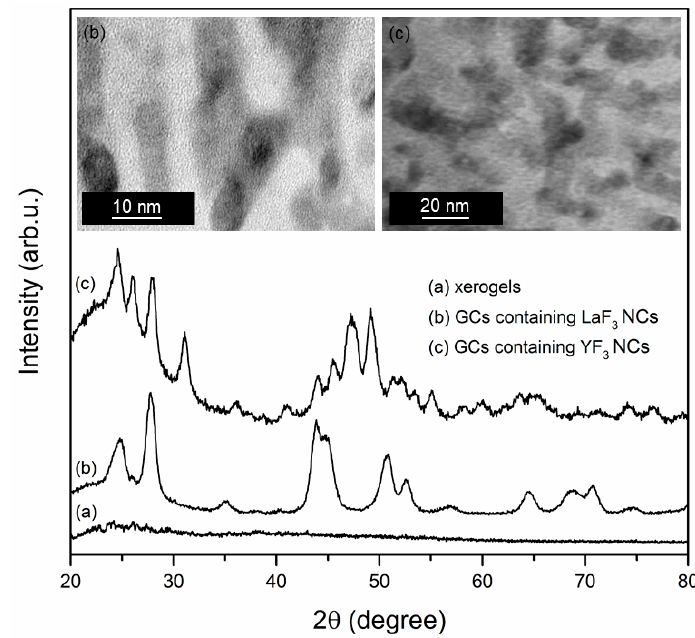
Figure 1. Transmission electron microscope (TEM) images and X-ray di ff raction (XRD) patterns of fabricated xerogels and glass-ceramic samples.